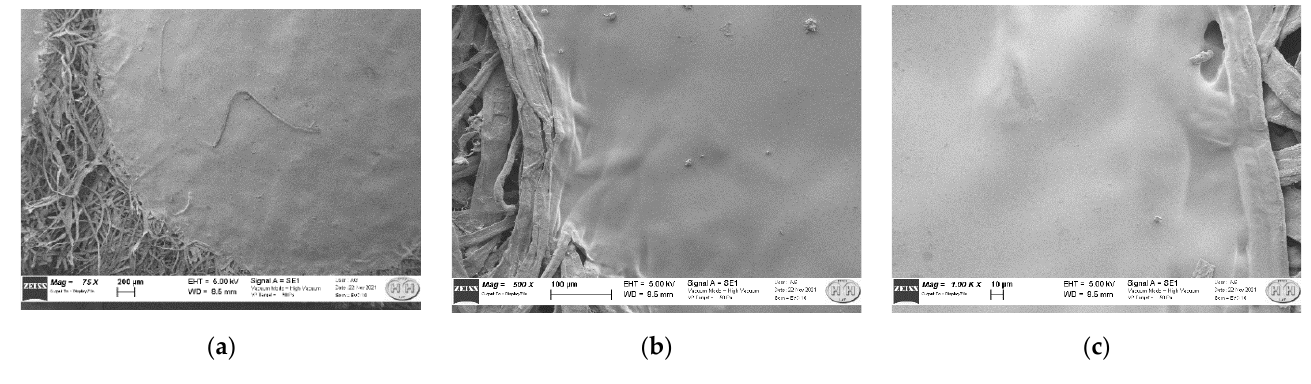
Figure 7. SEM images of CR-CMC@/Cell sensor at 75× ( a ), 500× ( b ) and 1000× ( c ).